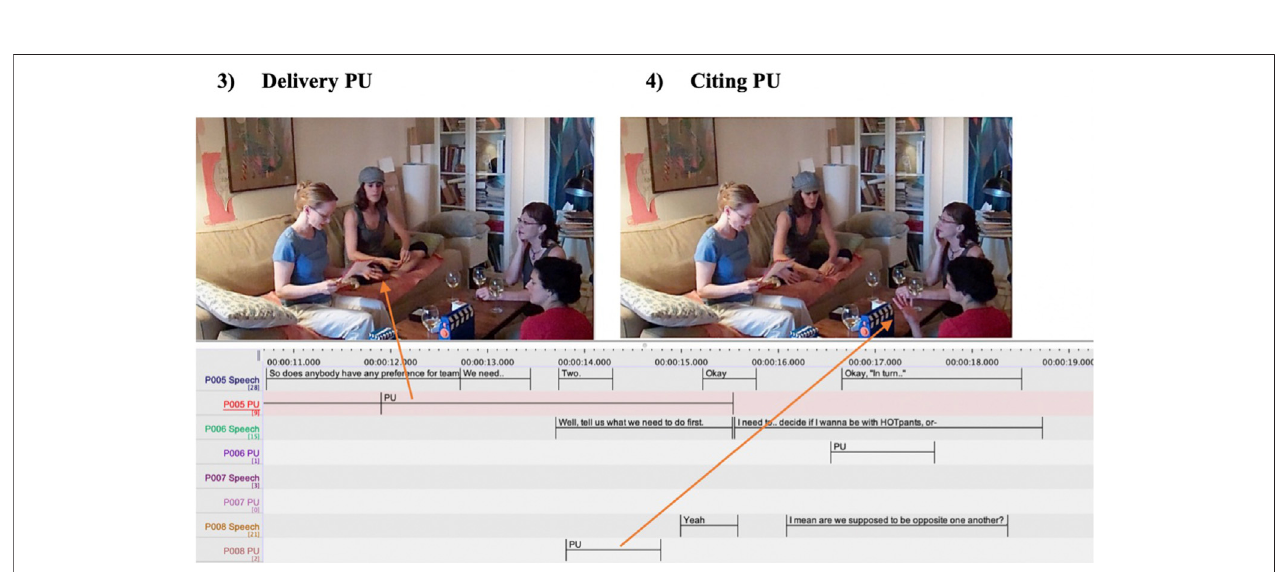
FIGURE 11 | Delivery and citing PU in American English.